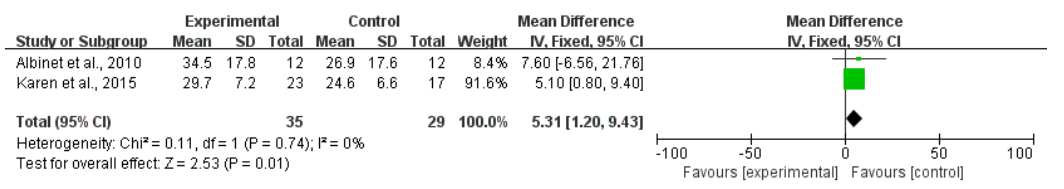
Figure 8. Forest plots of TMT scale outcomes in overall analysis [16,18,27].